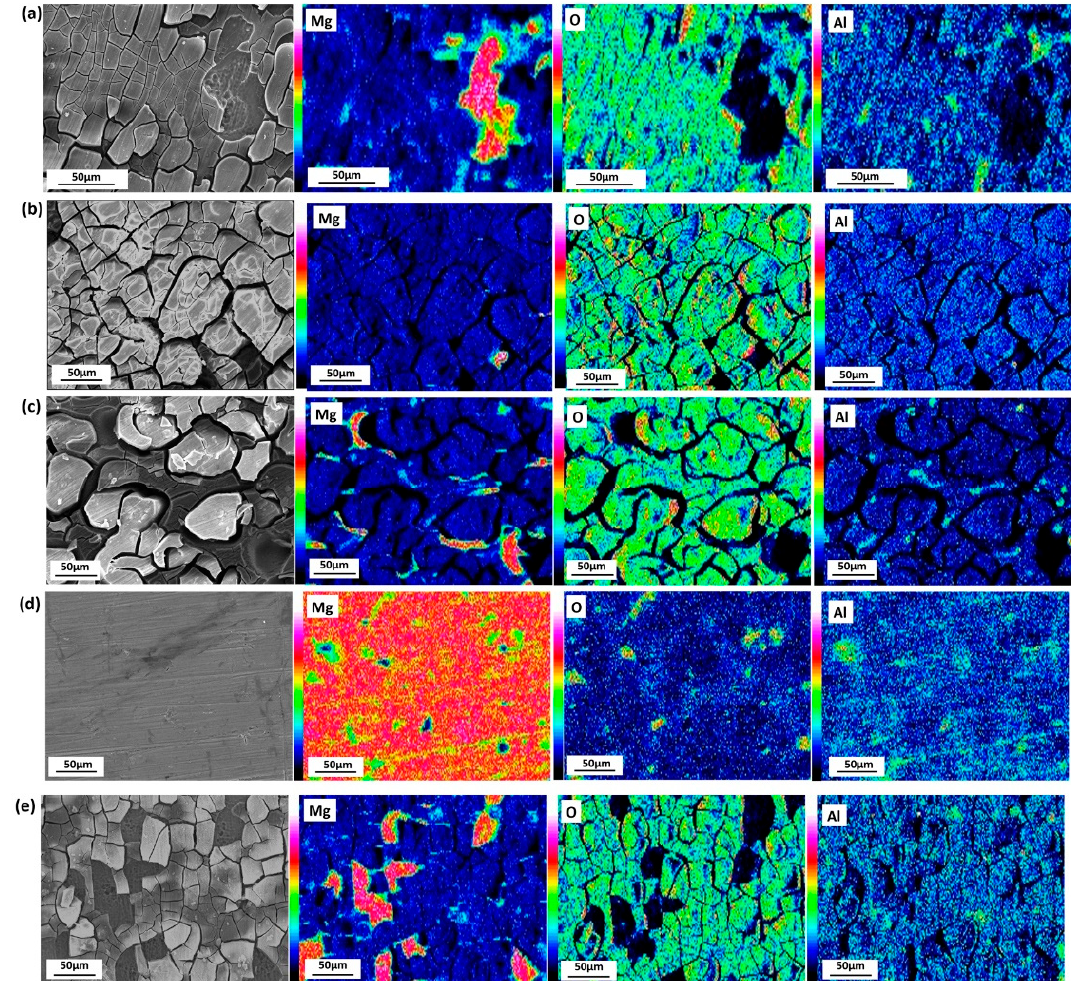
Figure 10. SEM images and corresponding X-ray maps of Mg, Al and O for AZ91D after immersed in simulated HA solution ( a ), and solutions at the shortage of SO 2 − days. 11